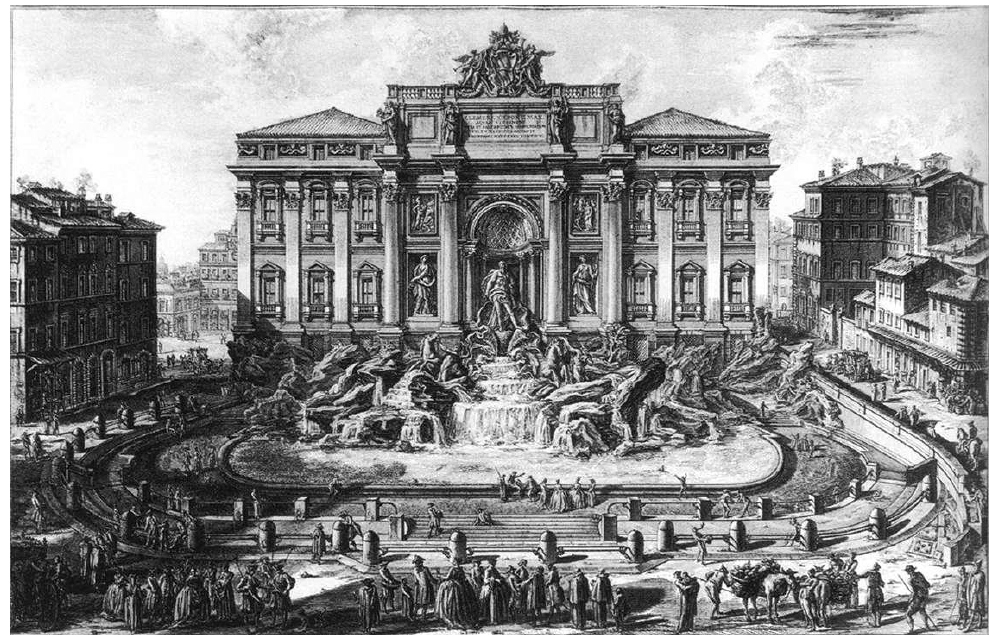
Figure 8. Giovan Battista Piranesi, The Trevi Fountain in Rome, copper engraving, 1773.